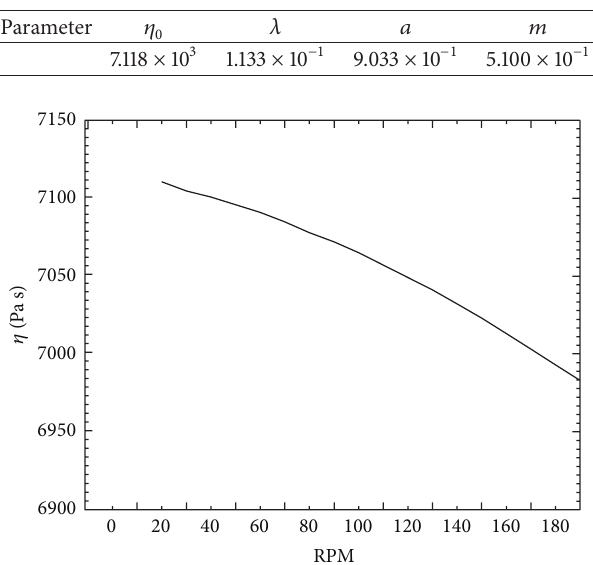
Table 1: Values for the parameters of the Carreau-Yasuda viscosity model for PLA with 𝑀 𝑤 = 130000 kg/kmol [25].